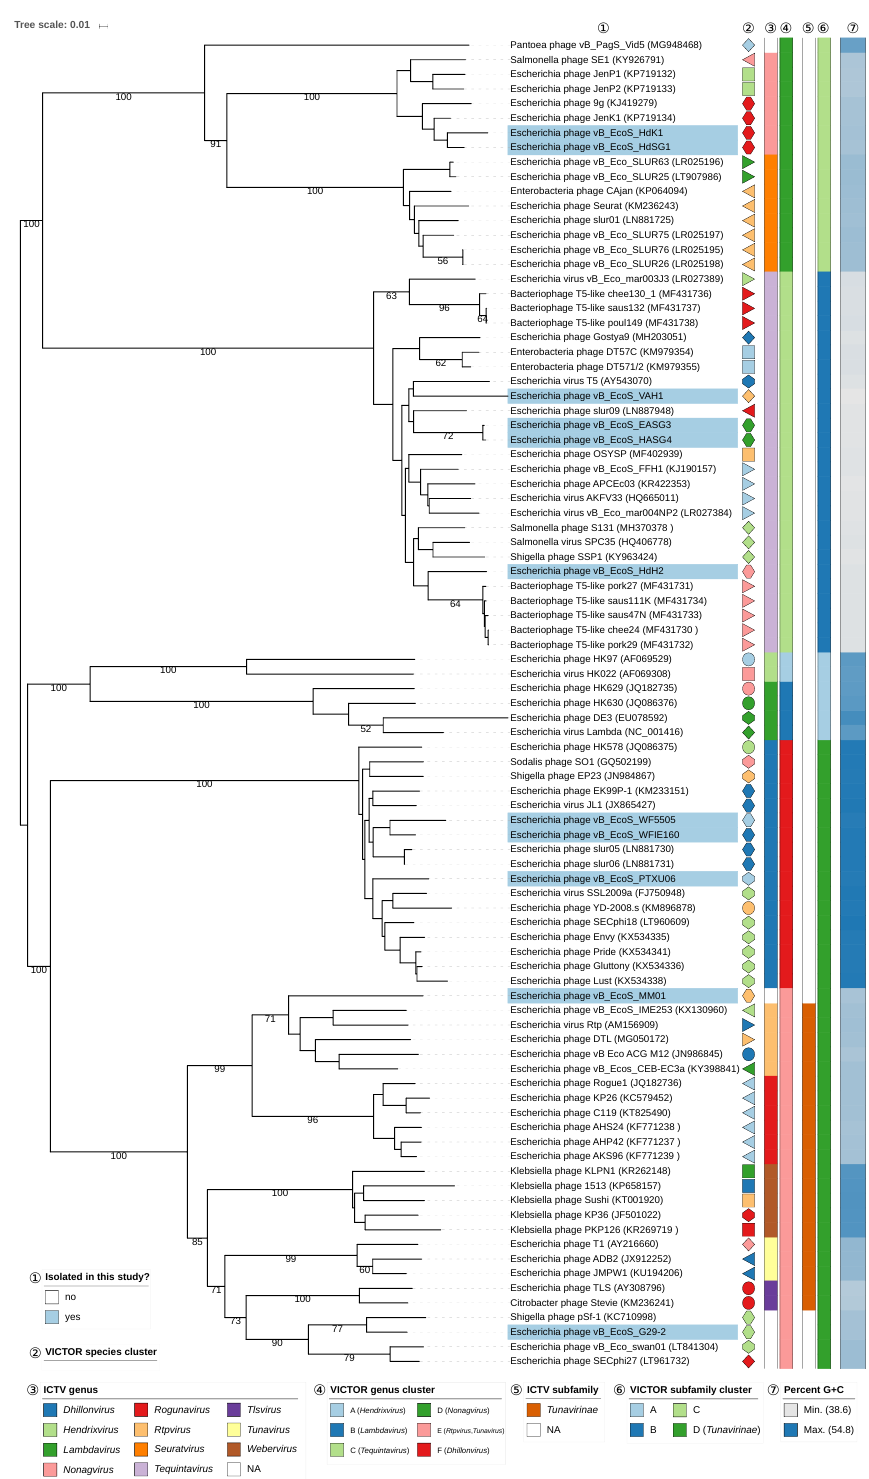
Figure 6. Phylogenomic analysis of Siphoviridae members of this study at the amino acid level using VICTOR. The recommended VICTOR tree (formula d 6 ) is shown and the numbers listed above the branches are GBDP pseudo-bootstrap support values from 100 replications, given that branch support exceeds 50%. The branch lengths of the resulting VICTOR trees are scaled in terms of the used distance formula. Annotations are given to the right-hand side of the tree: indicator for newly isolated phages (1), genera and subfamilies according to ICTV (3,5), species, genus, and subfamily cluster proposed by VICTOR (2,4,6), and genomic G + C content